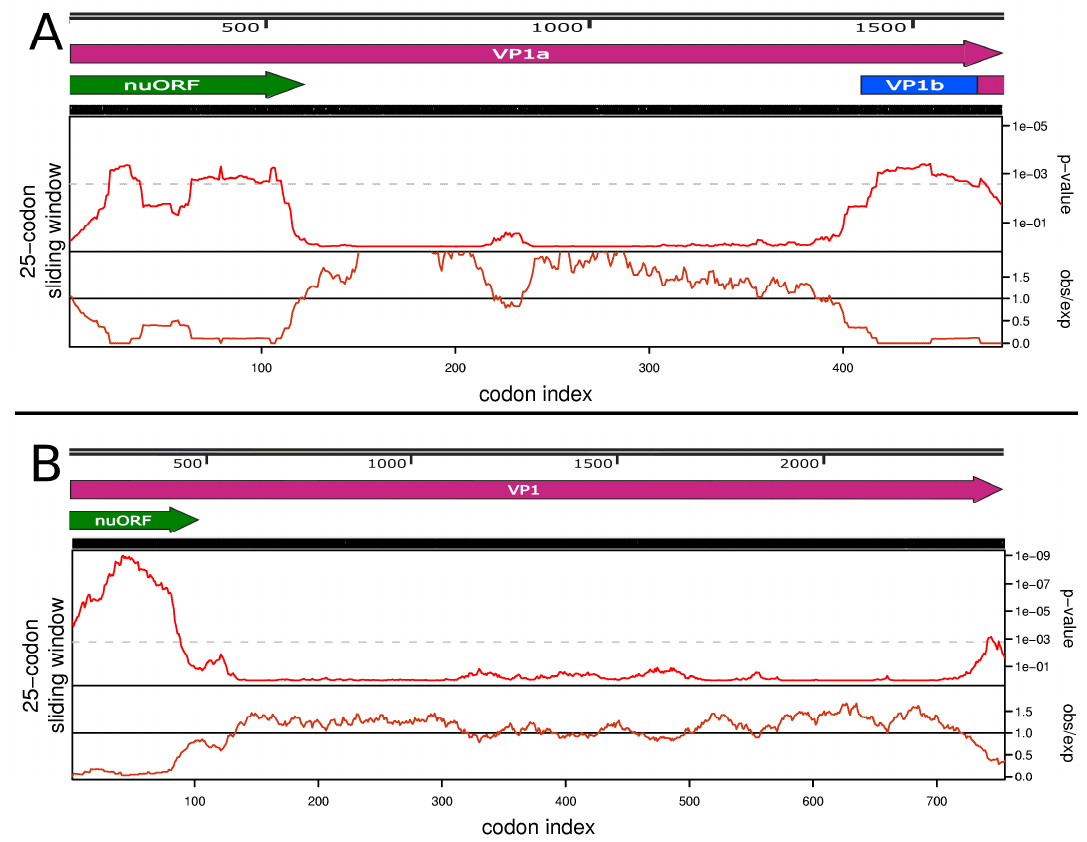
3 Figure 6. Association of the novel upstream open reading frame (nuORF) with the region of high conservation in the Alongshan virus VP1a and Jingmen tick virus VP1 open reading frames. ( A ) Codon alignment of 7 full sequences of the Alongshan virus VP1a open reading frame (ORF) was used in the analysis (Table S2). ( B ) Codon alignment of all 25 full sequences of the Jingmen tick virus VP1 ORF was used in the analysis (Table S2). In each section, the top panel represents the virus genome map of the tested region. The middle panel depicts the probability that the degree of ORF conservation within a 25-codon sliding window could be obtained under neutral evolution. The grey dashed line indicates p = 0.005 significance (after correcting for multiple tests, where the number of tests is the length of a coding sequence divided by the window size). The bottom panel displays the relative amount of synonymous-site conservation at a 25-codon sliding window by showing the ratio of the observed number of synonymous substitutions to the expected number. The analysis was done using the Synplot2 program